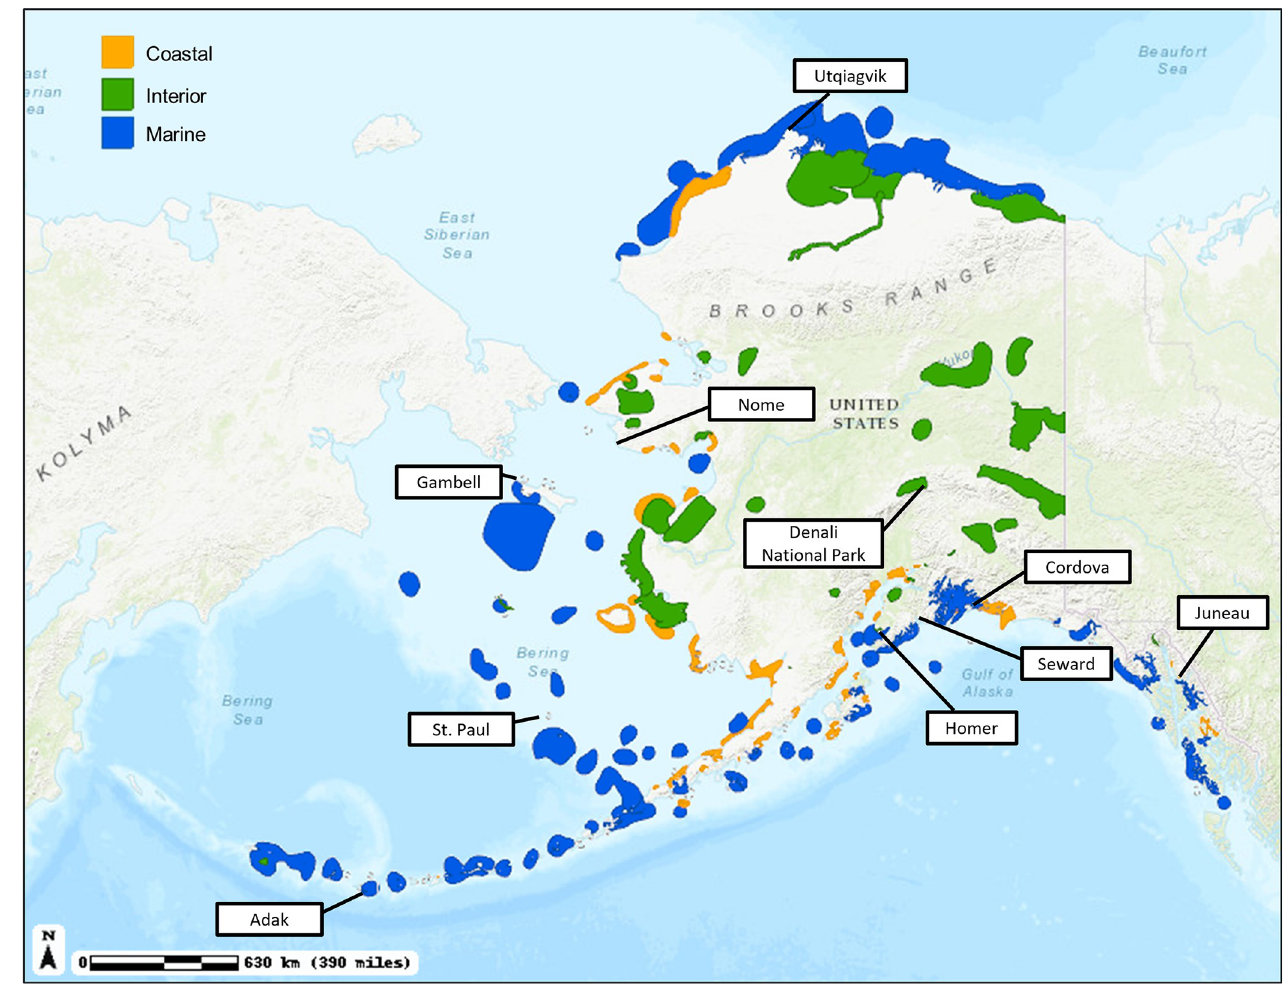
Fig 2. Alaska’s Important Bird Areas (IBAs) and communities that are birdwatching hotspots. The fourth region is the Western Alaska Bird Conservation Region which we refer to West- ern Alaska . It includes all of western coastal Alaska starting with the Northwest Arctic Borough to the North and ending with the Bristol Bay Borough and Kodiak to the South (Fig 1) [15]. High densities of breeding waterfowl and shorebirds are common especially during migration including Dunlin ( Calidris alpine ), Western Sandpiper ( Calidris mauri ), Red Knot ( Calidris canutus ), and Bar-tailed Godwit ( Limosa lapponica ). Wintering sea ducks such as Steller’s Eider ( Polysticta stelleri ), Harlequin Duck ( Histrionicus histrionicus ), Surf Scoter ( Melanitta perspicillata ), and Black Scoter ( Melanitta Americana ) can be found along the Alaska Penin- sula coast. This region is also roadless and supports the world’s largest wild commercial salmon fishery in Bristol Bay [28]. Bristol Bay, the Yukon-Kuskokwim Delta, and Safety Sound near Nome host some of the largest congregations of waterfowl in North America, including the only nesting and breeding sites for the Emperor Goose ( Anser canagicus ), an important species for subsistence food and also a species of conservation concern due to declining popu- lations in the face of climate change. Nome and Gambell, a community on St. Lawrence Island in the Bering Straits are the region’s birding hotspots (Fig 2). The region’s mixed cash-subsis- tence economy is supported by commercial fishing [24,29].